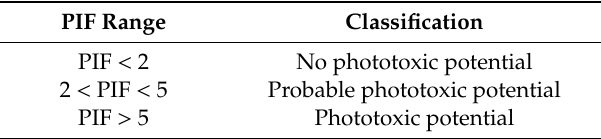
Table 1. Phototoxicity classification criteria per OECD 432 guidelines.